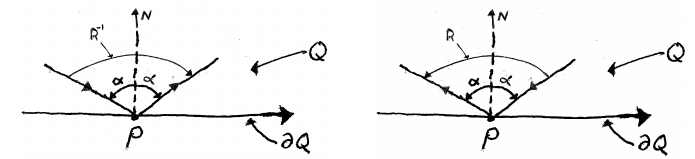
Figure 10. Reflection at a point P on ∂ Q .